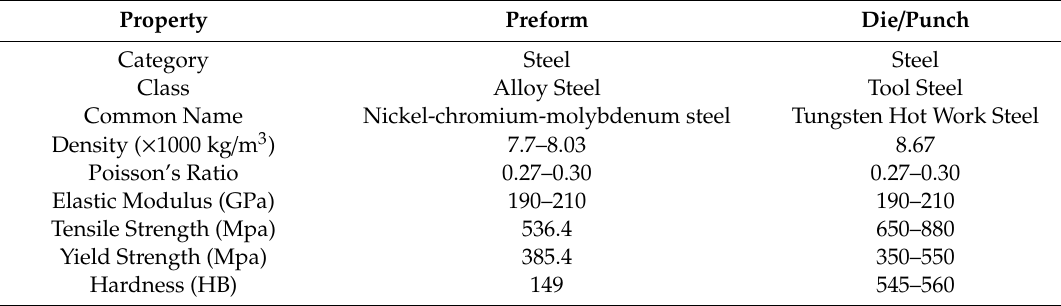
Table 3. Specifications of Die, Punch and